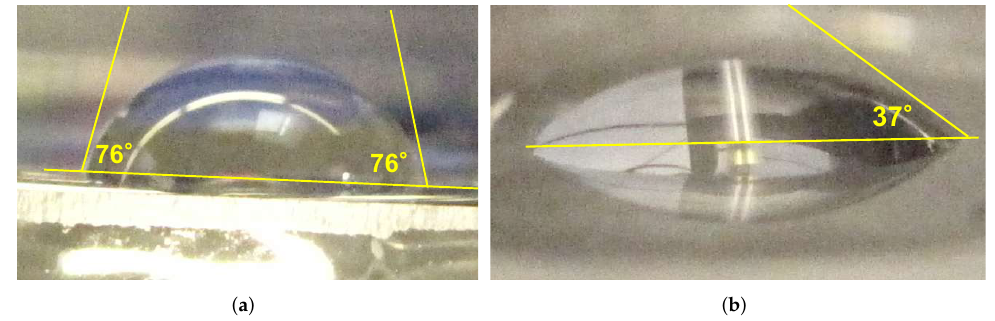
Figure 2. The droplets of the distilled water applied on the flat side of the PMMA lens ( a ) before treatment, and ( b ) after plasma treatment with nitrogen PDD at a distance of 6 mm, nitrogen flow of 8.0 SLM, and treatment time of 3